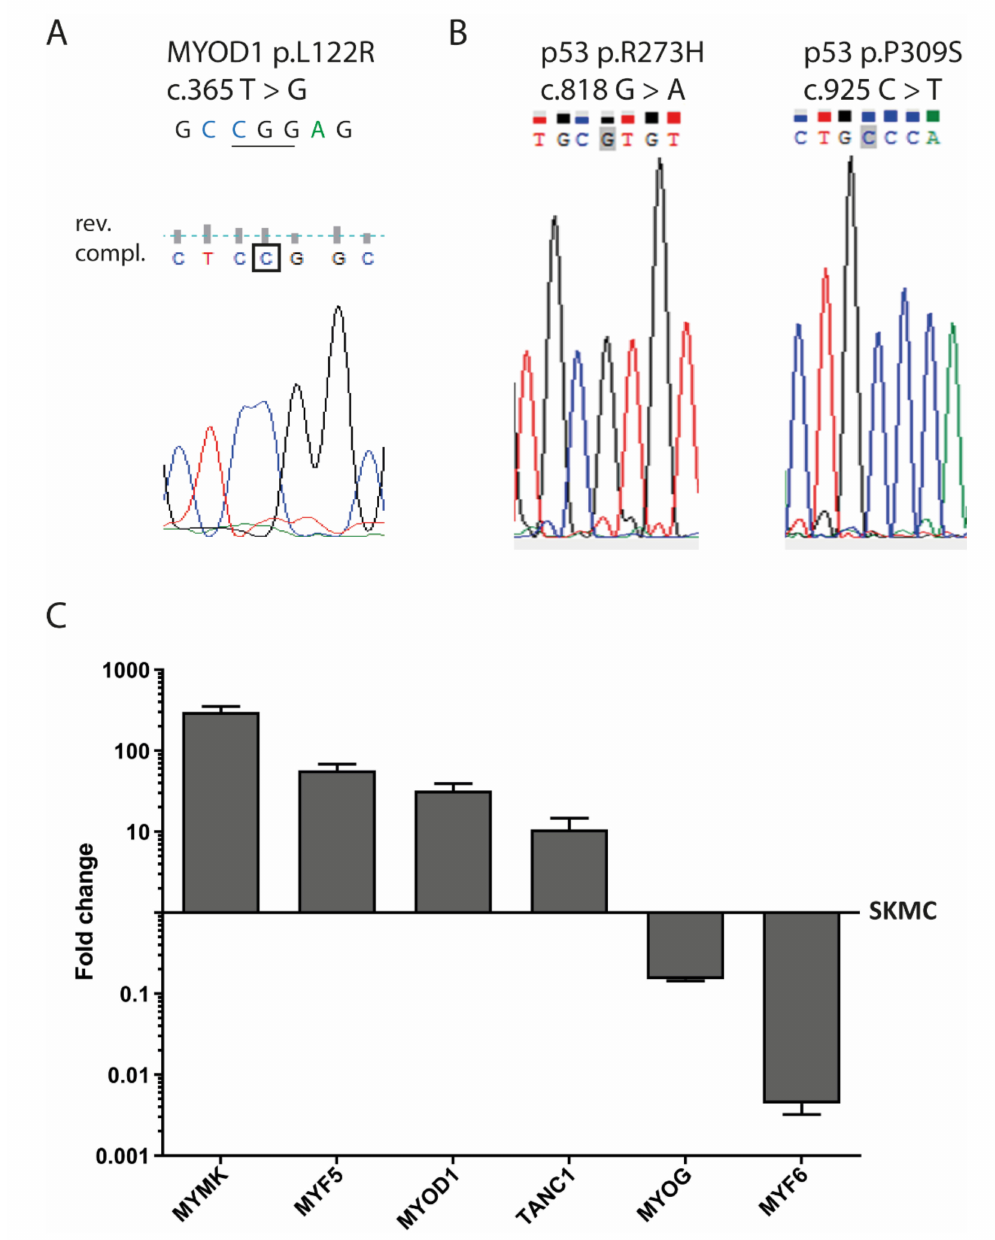
Figure 6. Mutation analysis and myogenic marker gene expression. Sanger sequencing of SRH cell genomic DNA showed mutations in the MYOD1 and TP53 gene ( A ) A MYOD1 c.365 T > G mutation was identified. For sequencing of MYOD1 a reverse primer was used. Therefore, the chromatogram shows the reverse complement sequence ( B ) Two TP53 mutations at c.818 G > A and c.925 C > T were detected. ( C ) The total RNA was extracted from the SRH cell line and human SKMC. Quantitative RT-PCR was performed for the genes MYMK , MYF5 , MYOD1 , TANC1 , MYOG , and MYF6 in triplicate and normalized to the housekeeping gene TBP . Expression levels relative to SKMC are shown. Error bars indicate the standard